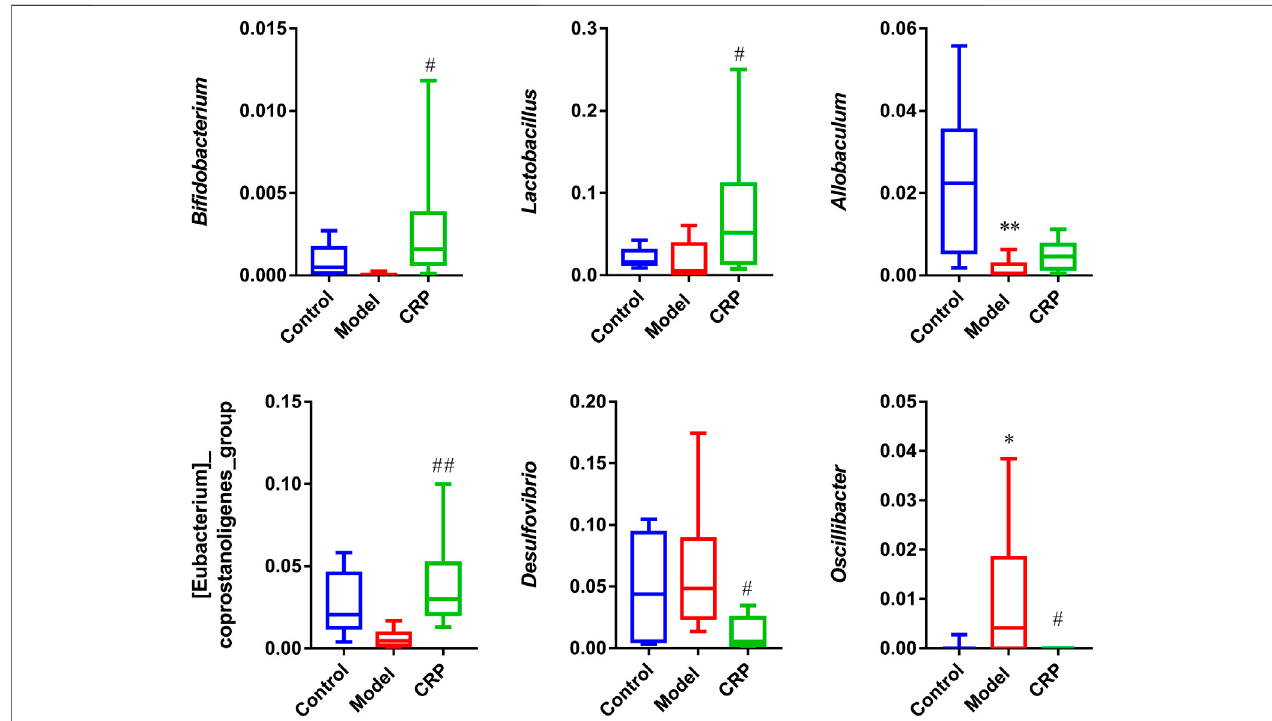
FIGURE 5 | Relative abundances of Bi fi dobacterium , Lactobacillus , Allobaculum , [Eubacterium]_coprostanoligenes_group , Desulfovibrio , Oscillibacter . ( n (cid:2) 10; * p < 0.05, vs. control group; # p < 0.05, vs. model group; ## p < 0.01, vs. model group.)